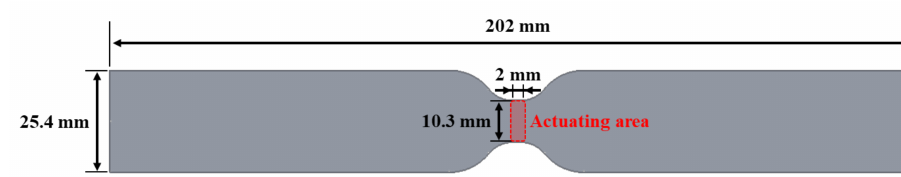
Figure 3. Specification of aluminum foil specimen.